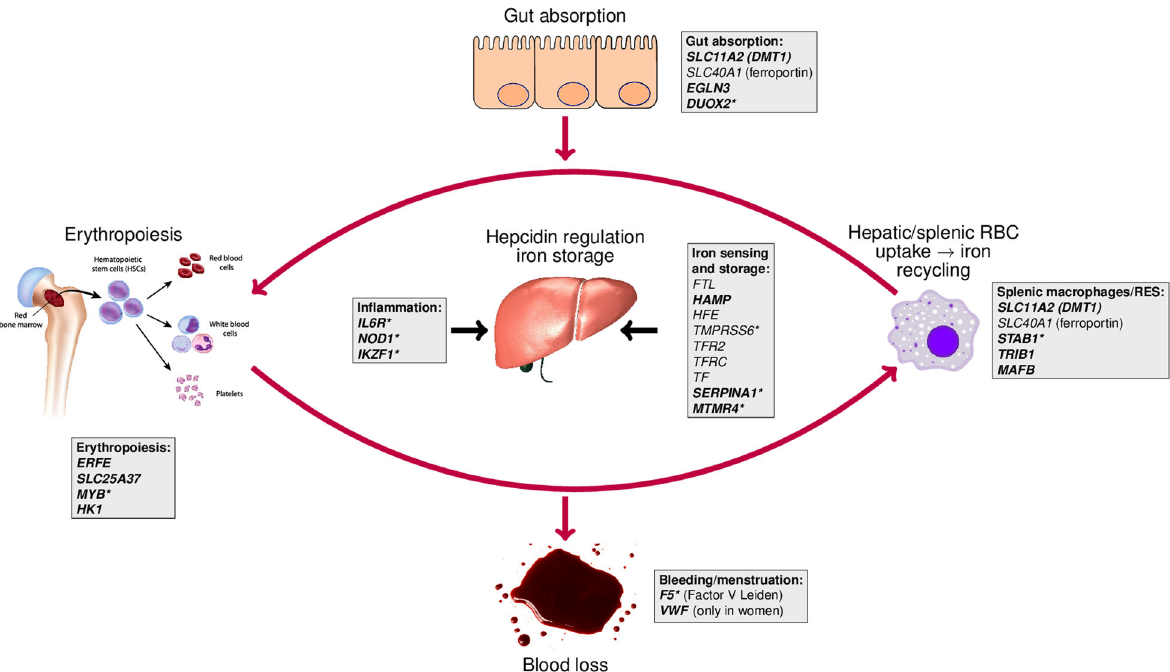
Fig. 4 Iron homeostasis loci in the context of systemic iron homeostasis, categorization into main physiological processes. Novel loci are in bold font. *Gene with a predicted probability of being causal (based on a variant-to-gene algorithm, see “ Methods ” ) larger than 50%. The liver, blood spot, and erythropoiesis/hematopoiesis cartoons were bought from Shutterstock (standard license), the macrophage is from Wikimedia Commons